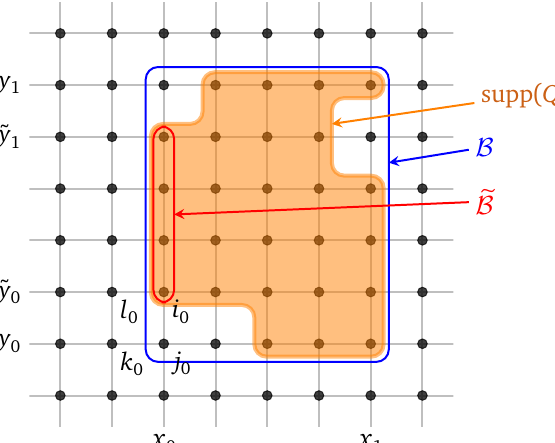
Figure 26: Support of a local operator Q , supp ( Q ) (in orange), is fully located inside a rectangle B ≡ [ x leftmost column of B is a set (cid:101) B ≡ { x always identify the lowermost site i